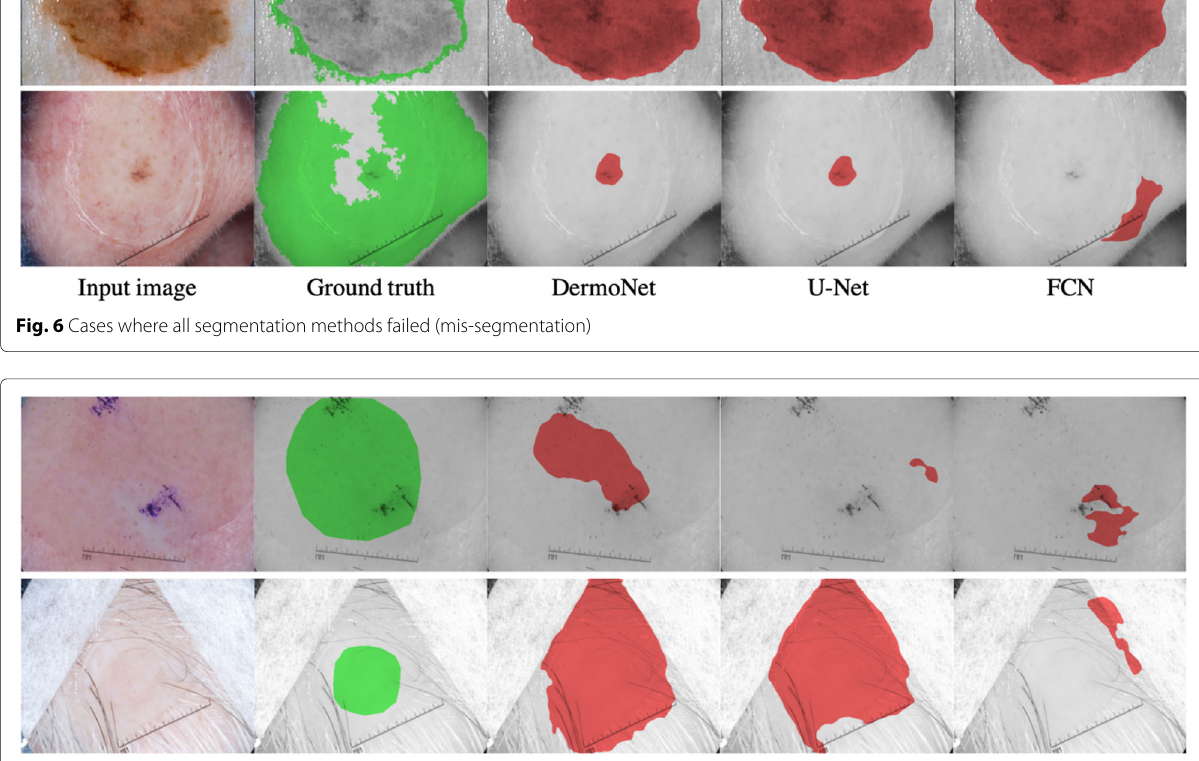
Fig. 7 Cases where the results of all the networks are